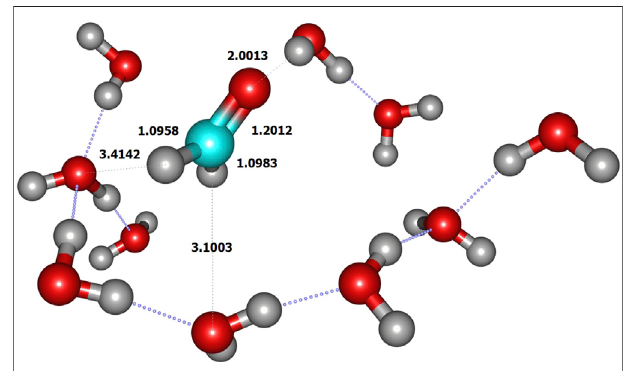
FIGURE 2 | Reactant geometry (limited to QM